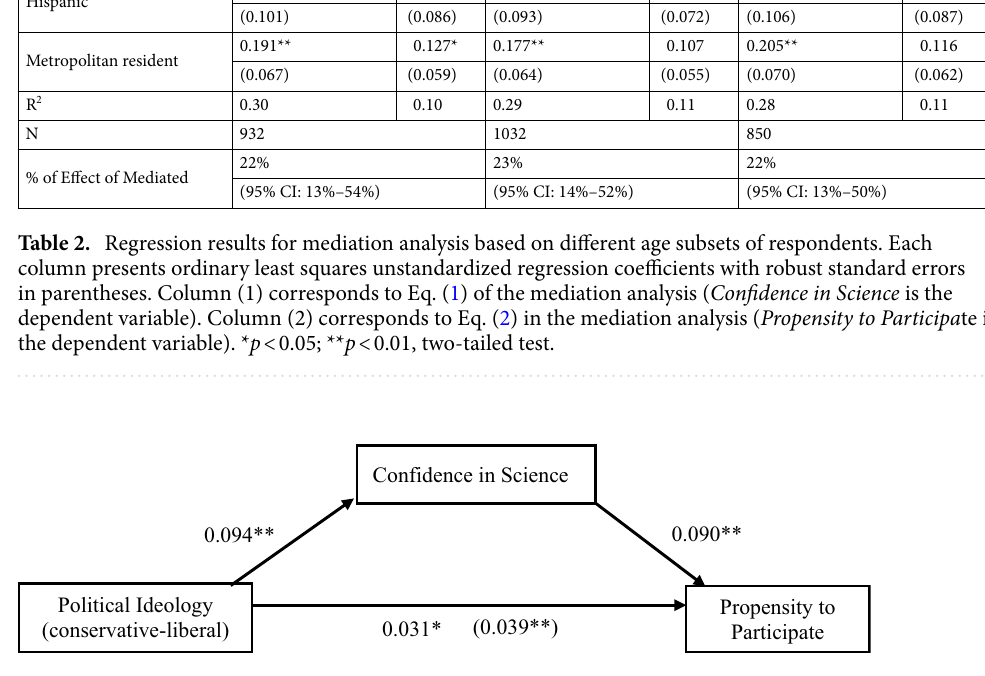
ideology. Those with a conservative ideology have a systematically lower propensity, due in part to their lower levels of trust in science. This is consistent with the previous findings regarding participation in a hypothetical